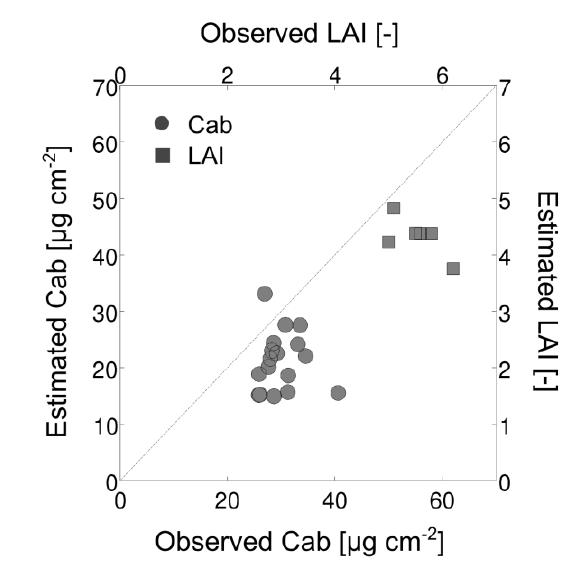
Figure 3. Comparison of estimated chlorophyll content (Cab) and leaf area index (LAI) with the ground measurements collected at the beech research site. The best SVR model for Cab estimation was based on CR 645-710 nm (RMSE = 10.9 µg cm -2 ) and for LAI estimation on CR 680-800 nm (RMSE = 1.4). The results complement the maps in Figure